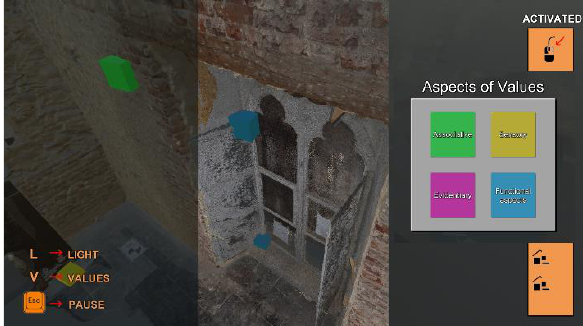
Figure 15. This figure illustrates the possibility of creating new values, defining the related aspect of value, and providing a description. The image also shows the integration of a point cloud and high poly textured mesh generated with